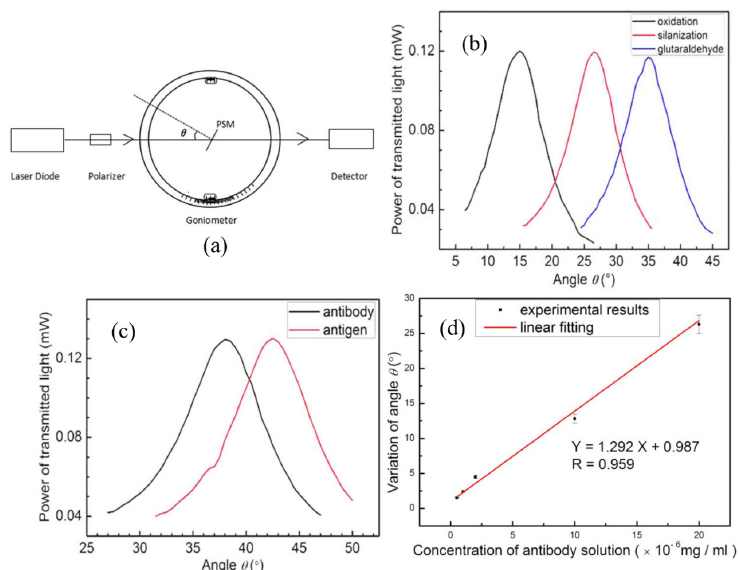
Figure 8. ( a ) Schematic of the spectrometer-free PSM method. ( b ) Shift in transmission angular spectrum during the surface functionalization. ( c ) Shift by the antigen-antibody. ( d ) Measurement results for the concentrations of the hydatid antigen. Reproduced from Open Access Article [61] in Springer